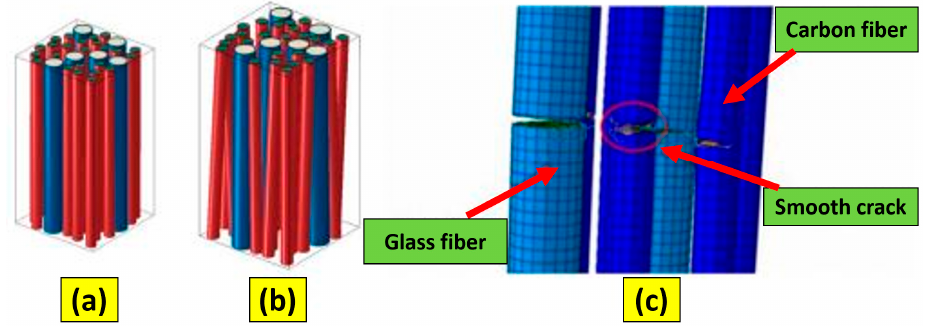
Figure 5. Hybrid composite ( a ) aligned [48] and ( b ) misaligned [48]. ( c ) Image of the hybrid composite crack [43].